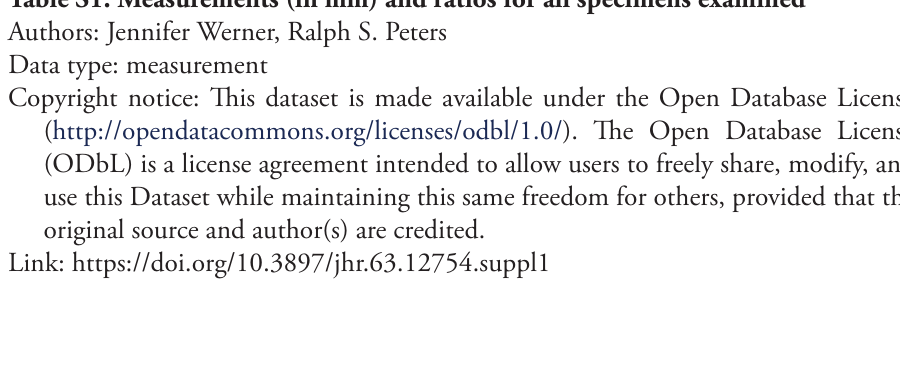
Table S1. Measurements (in mm) and ratios for all specimens examined Authors: Jennifer Werner, Ralph S.